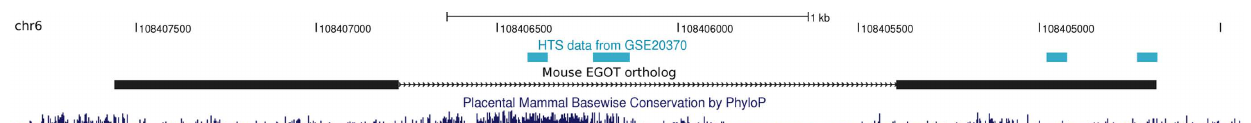
FIGUREA5 | Non-coding RNA profiling by high throughput sequencing reveals extragenic Pol-II transcription sites at the mouse EGOT ortholog. The deep sequencing data from (De Santa et al., 2010) available in the Gene Expression Omnibus (under GEO accession number GSE20370) confirm transcription of the intronic highly conserved element (HCE) and parts of the 3 (cid:2) -end of the mouse EGOT ortholog. Although the data do not validate the full mouse ortholog, we benefit twice from the